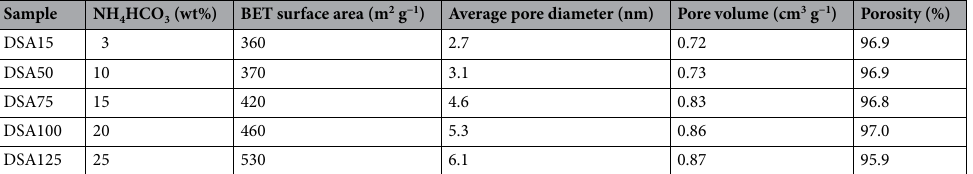
Table 1. Ammonium bicarbonate concentrations used to prepare silica aerogel samples and resulting physical properties.